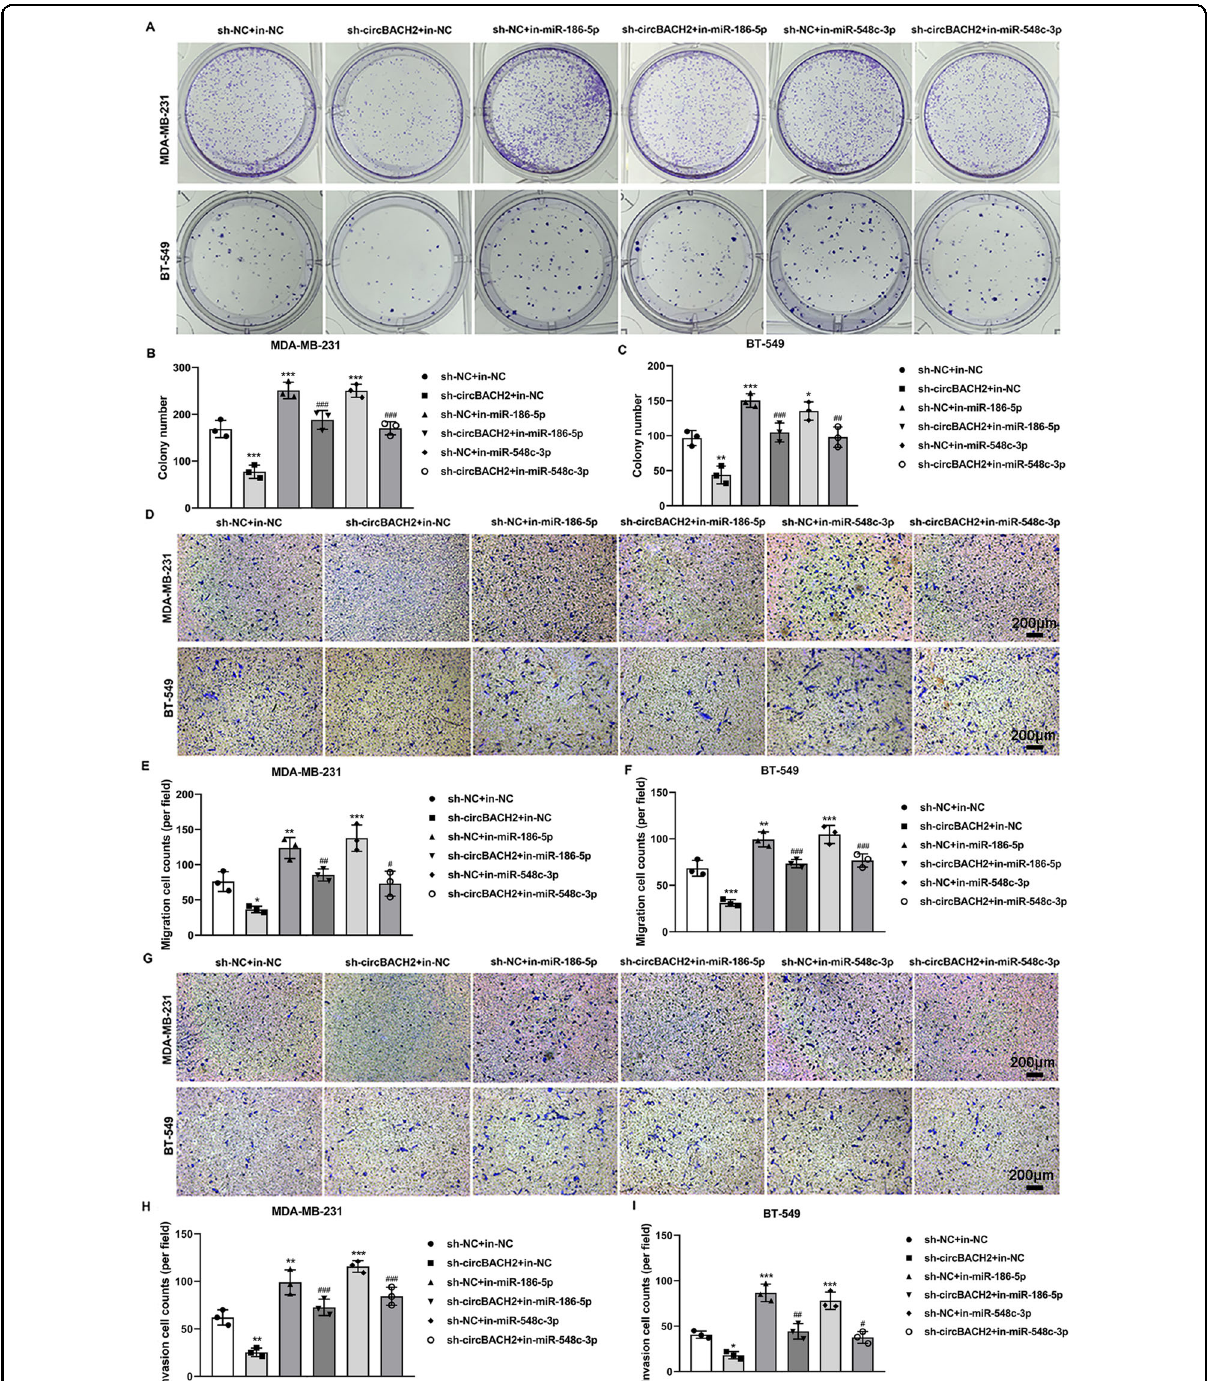
Fig. 7 miR-186-5p and miR-548c-3p mediated the regulatory effect of circBACH2 on the progression of TNBC in vitro. MDA-MB-231 and BT- 549 cells were divided into six groups: sh-NC + in-NC, in-NC + sh-circBACH2, sh-NC + in-miR-186-5p, sh-circBACH2 + in-miR-186-5p, sh-NC + in-miR- 548c-3p, and sh-circBACH2 + in-miR-548c-3p. A – C Cell proliferation was evaluated using colony formation assay and quanti fi ed. D – F Cell migration was evaluated using Transwell assay and quanti fi ed. G – I Cell invasion was evaluated using Transwell assay and quanti fi ed. * P < 0.05, ** P < 0.01, *** P < 0.001 vs sh-NC + in-NC; # P < 0.05, ## P < 0.01, ### P < 0.001 vs in-NC +